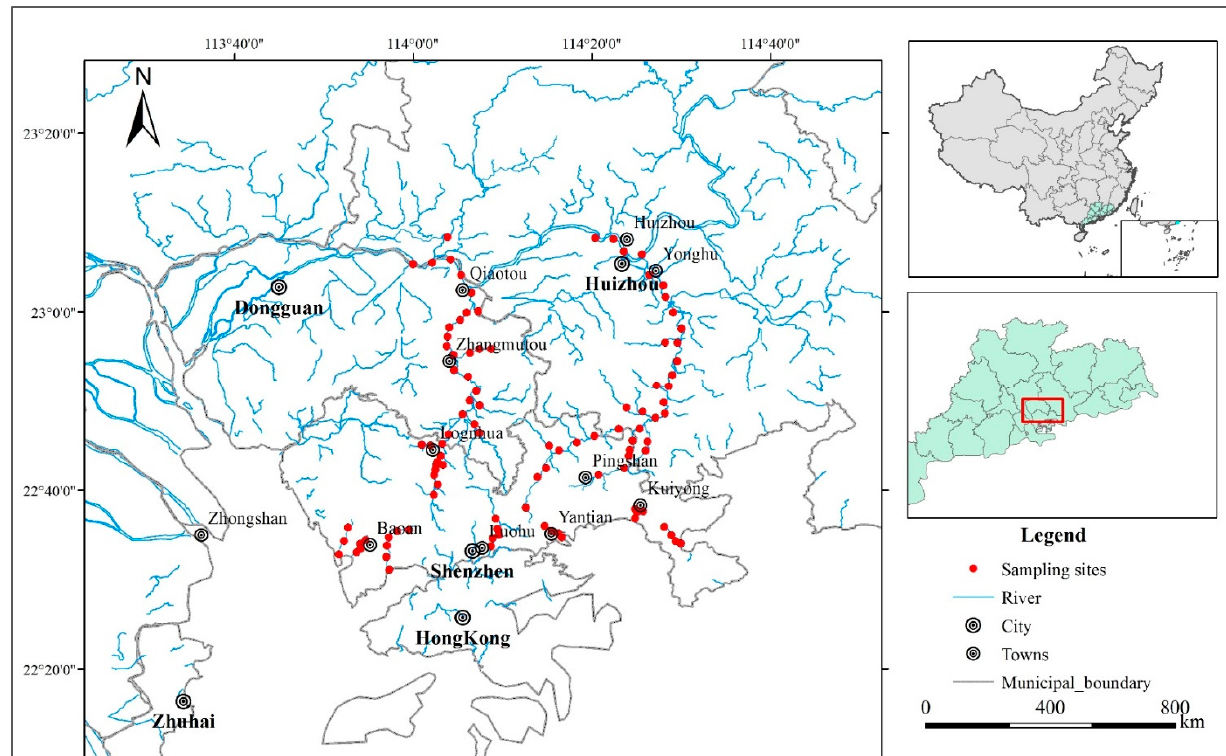
Figure 1. The study area and sampled sites in Shenzhen and adjacent areas, South China.